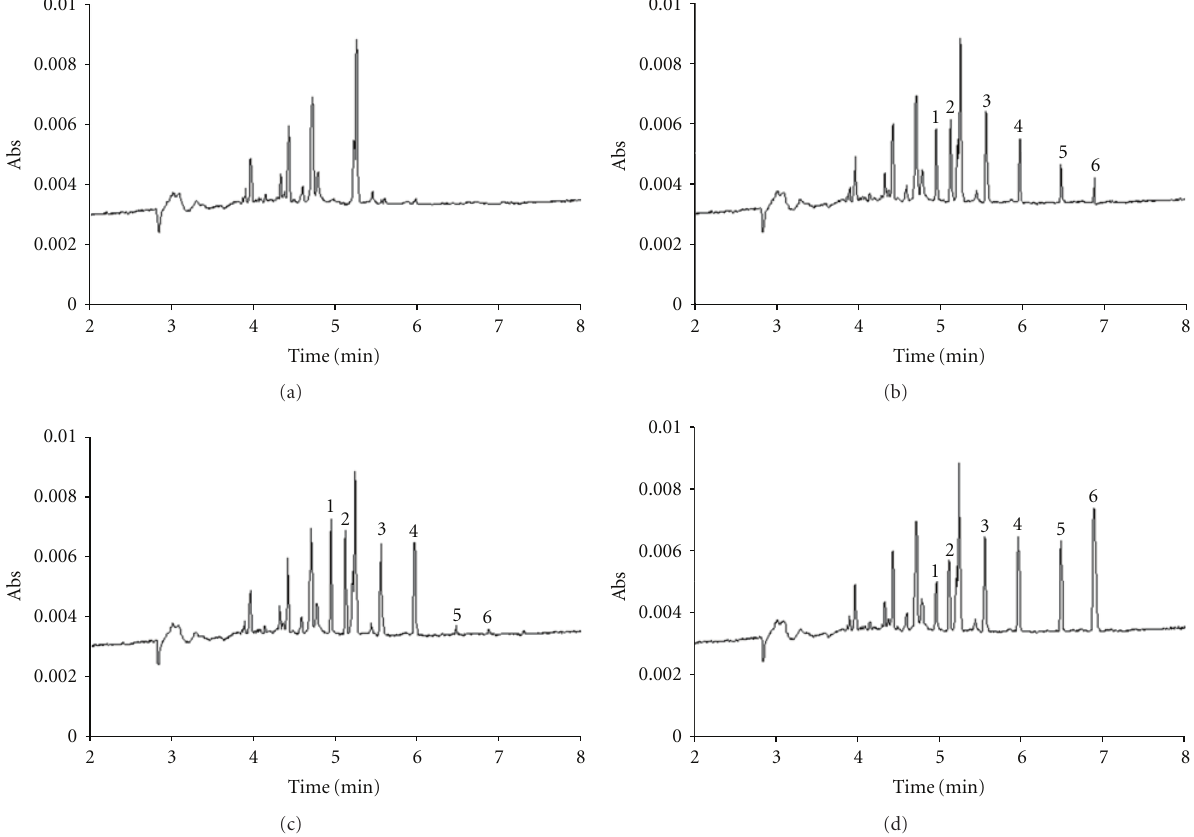
Figure 1: Typical electropherograms obtained for (a) steroid-free urine sample; (b) male urine sample; (c) female urine sample; (d) urine sample spiked with 50 ng/mL of cortisol (1), 50 ng/mL of cortisone (2), 200 ng/mL of dexamethasone (3) (I.S.), 100ng/mL of corticosterone (4), 100 ng/mL of testosterone (5), and 100ng/mL of epitestosterone (6). Conditions of electrophoretic separation: 17kV, injection 2s, UV, λ = 254 nm, running electrolyte: 20 mM Na 2 B 4 O 7 , 25 mM SDS.